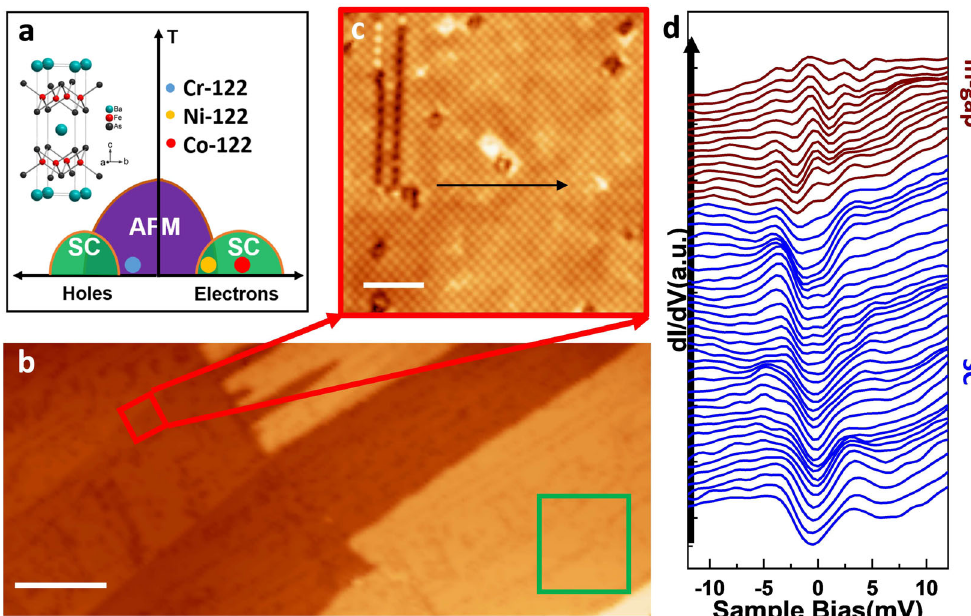
Fig. 1 Morphology and electronic structure of Ba(Fe 0.96 Ni 0.04 ) 2 As 2 . a The phase diagram of BaFe 2 As 2 under doping concentration variation. The inset is the crystal structure of the parent compound BaFe 2 As 2 . b The large scale STM topography image of Ni-122, V Bias = − 20 mV, I t = 100 pA. The red and green boxes mark the locations of ( c ) and Fig. 2a, respectively. The scale bar represents 30 nm. c Atomically resolved STM image of Ni-122 surface ( V Bias = − 100 mV, I t = 400 pA) shows √ 2 × √ 2 reconstruction, the scale bar represents 3 nm. d Sets of STS spectra along the black arrow in ( c ) show local electronic inhomogeneity. The blue and brown curves show superconducting and in-gap states as labeled. Curves are shifted vertically for different bulk property regions (bulk SC, magnetism, and SC coexistence, and non-SC). These are the bulk SC Ba (Fe 0.92 Co 0.08 ) 2 As 2 (Co-122) crystal, the AFM and SC coexisting Ba (Fe 0.96 Ni 0.04 ) 2 As 2 (Ni-122) crystal, and the AFM Ba(Fe 0.96 Cr 0.04 ) 2 As 2 (Cr-122) crystal. Since Ni (Cr) doping introduces twice the number of electrons (holes) in the FeAs layer as that of Co doping (from simple electron counting), we select the Co-122 doping level as 0.08 instead of 0.04 to achieve the same amount of electron versus hole doping levels per Fe atom. This ensures consistency across the three sets of samples. Cr-122 has a G-AFM ground state ( T N ~100 K), while optimally doped Co-122 is in the SC state ( T c ~22 K) 24 ; and the composition of the Ni-122 was chosen to locate it in the coexistence range of SC and AFM orders ( T c ~19 K, T N ~45 K). All the scanning tunneling microscopy/spectroscopy experiments are performed at the base temperature of ~4 K. These phases are indicated using blue, red, and yellow balls in the temperature-composition ( T − x ) phase diagram in Fig. 1a; the crystal structure of the undoped parent 122-unit cell is in the inset. After low-temperature cleavage, the three sets of samples show similar topography, which is the coexistence of 2 × 1 and √ 2 × √ 2 reconstructions, as reported for Co-122 before 25,26 . Figure 1b shows a typical large-scale topographic image of Ni- 122, with terraces, steps in 0.7 nm (half unit cell in c -axis), and defects. The atomic resolution image collected from the red box of Fig. 1b reveals the √ 2 × √ 2 reconstruction, atomic-scale dark pits, protrusions, and dark lines, as shown in Fig. 1c. The dark lines are the antiphase boundaries of the √ 2 × √ 2 domains, the dark pits are the results of missing single or multiple Ba atoms on the top surface, and the bright protrusions re fl ect the electronic contributions of the elemental defects beneath the Ba surface based on the height of the protrusion (~0.04 nm). Note that there exist height-variations of approximately 20 pm even on atom- ically well-ordered areas (~5 pm atomic corrugation from relative homogeneous areas), suggesting the existence of electronic inhomogeneity in the sample.